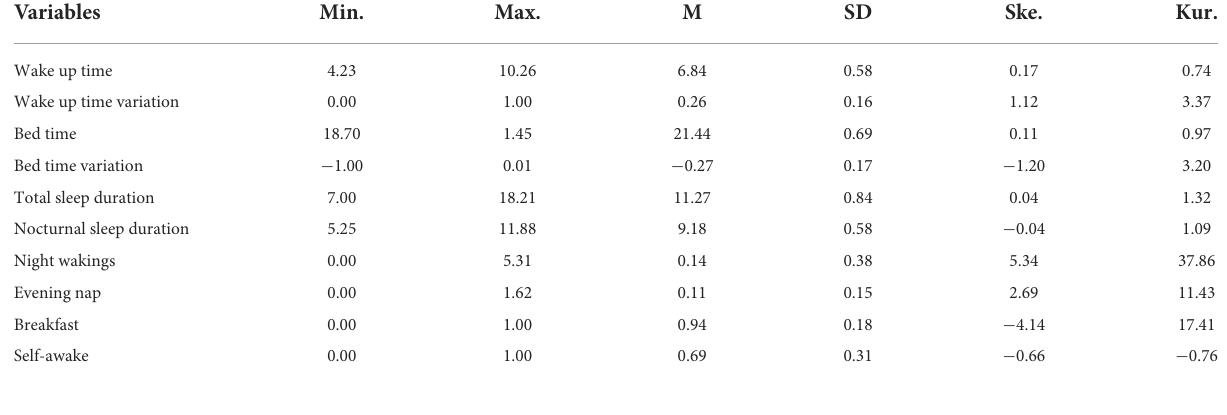
TABLE 1 Descriptive statistics of the various